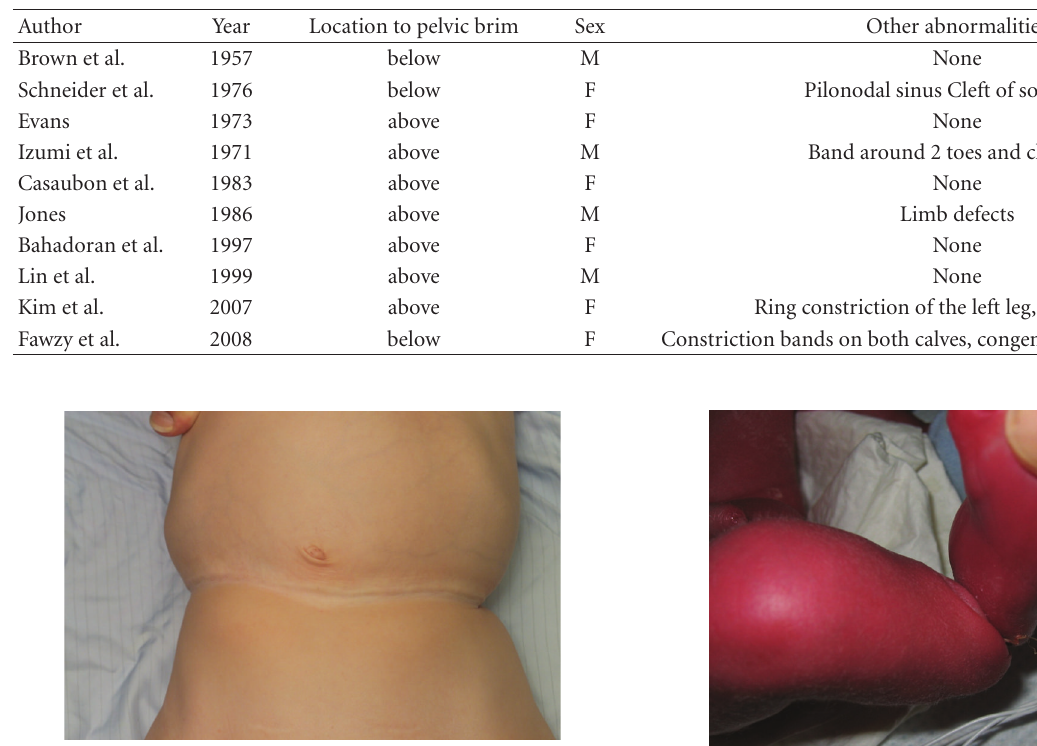
Figure 3: Appearance of pseudarthrosis of right leg at birth. A transtibial (below knee) amputation was later carried